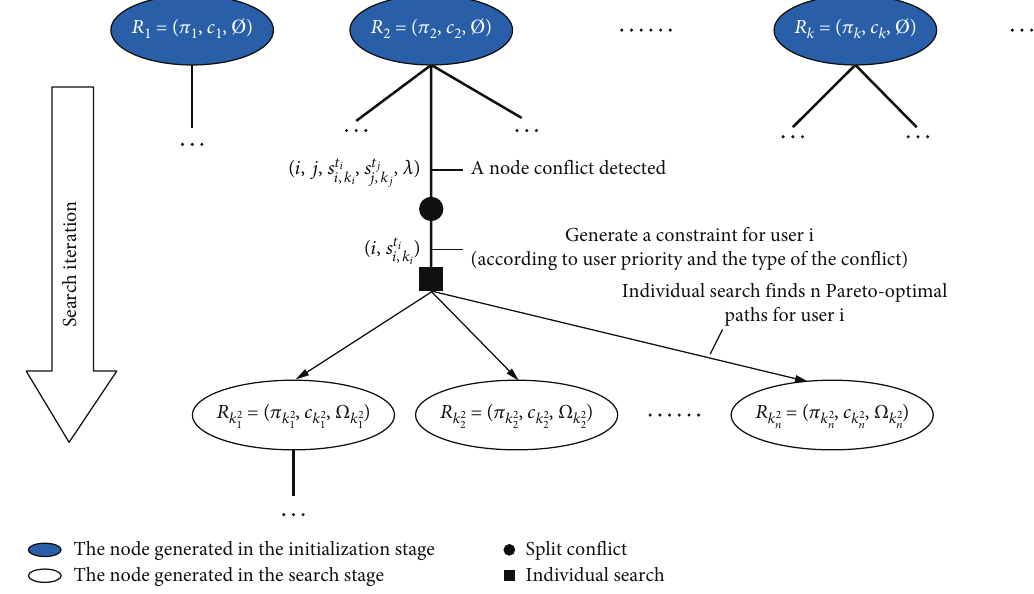
Figure 3: Search process of procedure (i.e., multiobjective single-agent path fi nding algorithm) to fi nd individual Pareto-optimal solution set O i